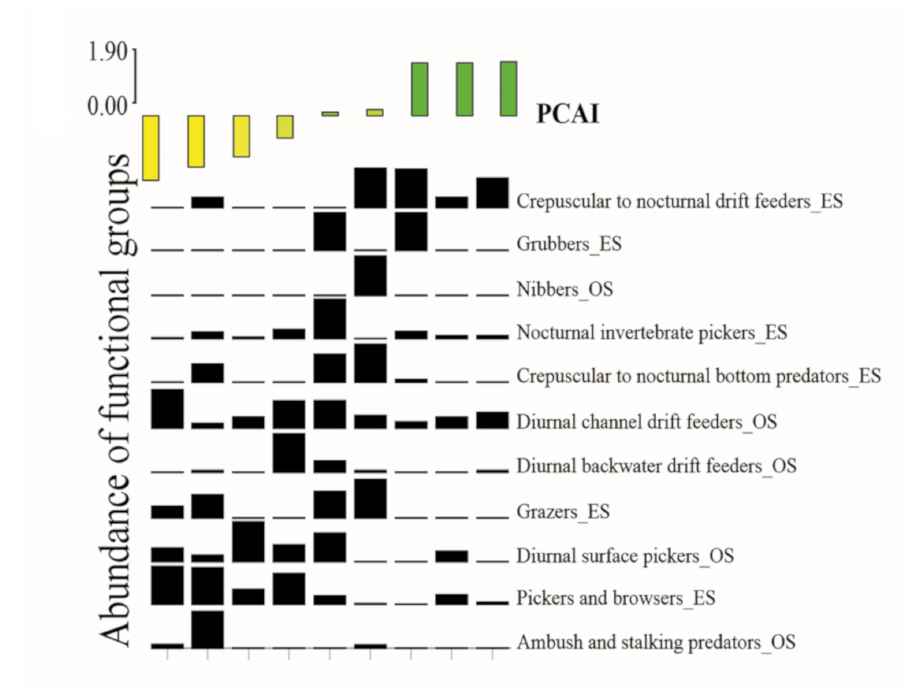
FIGURE 7 | Distribution of functional groups related to forest cover loss in Amazonian streams, state of Mato Grosso. OS: Opportunistic strategy; ES: Equilibrium strategy. Forest cover values vary from green (more forest cover) to yellow (less forest